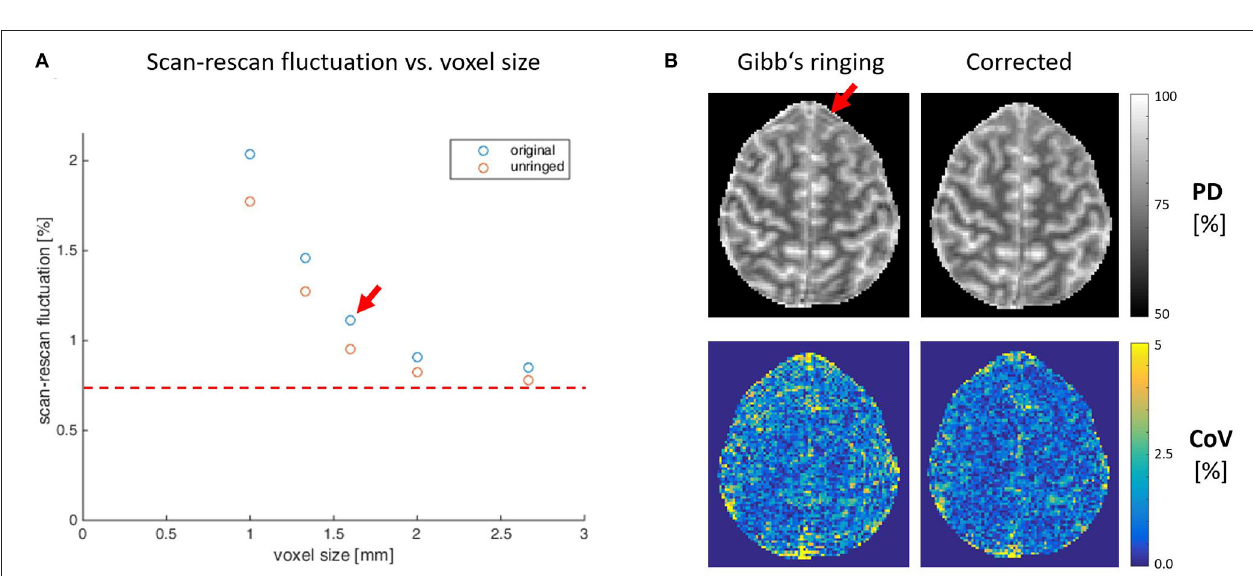
matter (PD: 12.2/-14.0%, MT: 33.3%, p 0.04; PD: 49.7%, p − − = − = R2 ∗ : 13.3/-12.1%). 46.0%, p 0.03; PD: 62.0%, p − − = − Figure 3A (lower row) shows the intra-subject variability of individual atlas regions in an example slice for a typical volunteer